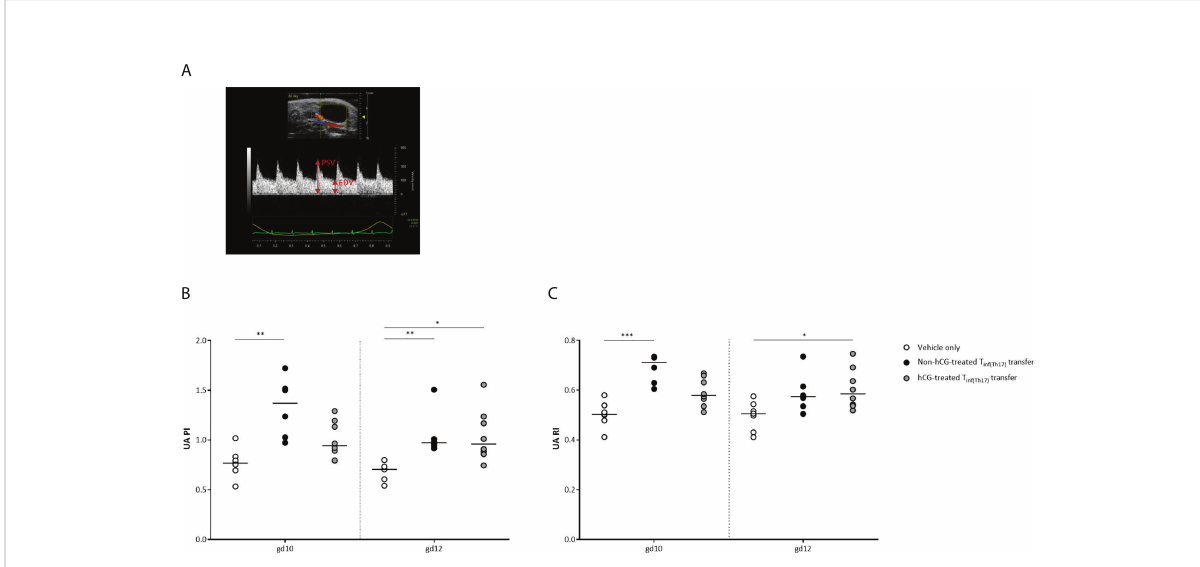
FIGURE 8 Adoptive transfer of T inf(Th17) cells resulted in abnormal blood- fl ow parameters in the maternal UA. Naïve CD4 + T cells were isolated by magnetic-activated cell sorting (MACS), polarized into Th17 cells under Th17-differentiating conditions for 3 days in vitro , in the presence or absence 500 mIU/ml rhCG, and then injected into pregnant CBA/J females during the fi rst 2 days of gestation. (A) Example of a Doppler fl ow diagram of the maternal UA, visualizing peak systolic velocity (PSV) and end-diastolic velocity (EDV). (B) Pulsatility index (PI) of the UA on gestational days (gd) 10 and 12 shown for vehicle-only ( n = 7), non-hCG-treated ( n = 6) and hCG-treated ( n = 8) groups. (C) Resistance index (RI) of the UA on gd 10 and 12. Data are presented as medians, showing individual values for each animal. For comparisons between experimental groups, the Kruskal – Wallis test followed by Dunn ’ s multiple-comparison test was used. Following, medians are provided for signi fi cant differences between groups for UA PI: 0.7677 vs 1.369 (gd10), 0.7046 vs 0.9715 (gd12) (vehicle only vs non-hCG-treated Th17 cells), 0.7046 vs 0.9601 (gd12) (vehicle only vs hCG-treated Th17 cells); for UA RI: 0.5027 vs 0.7107 (gd10) (vehicle only vs non-hCG-treated Th17 cells), 0.5055 vs 0.5847 (gd12) (vehicle only vs hCG-treated Th17 cells). * indicates p < 0.05; ** indicates p < 0.01; *** indicates p < 0.001. UA, uterine